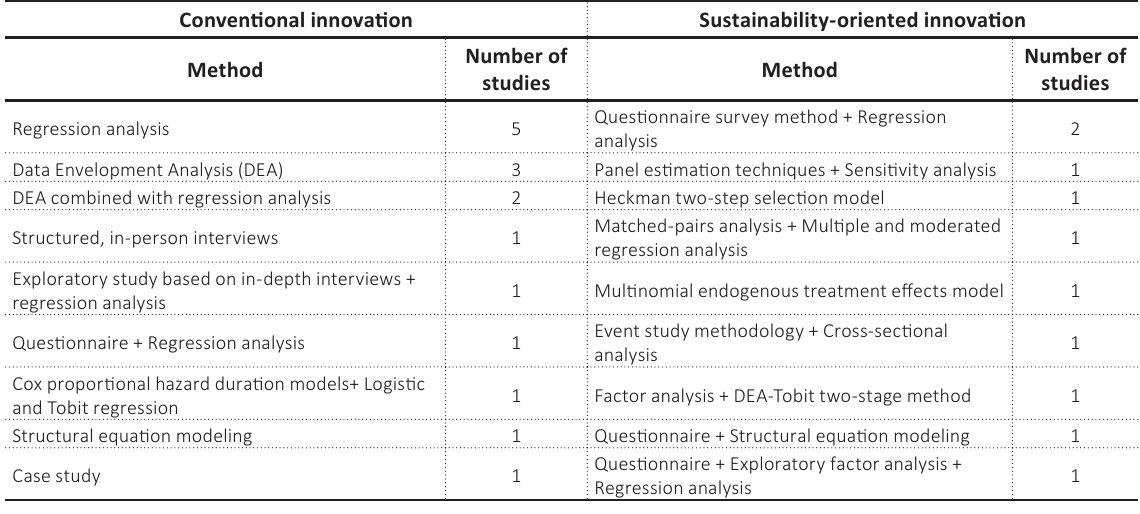
Table 3. A comparative overview of the methods used